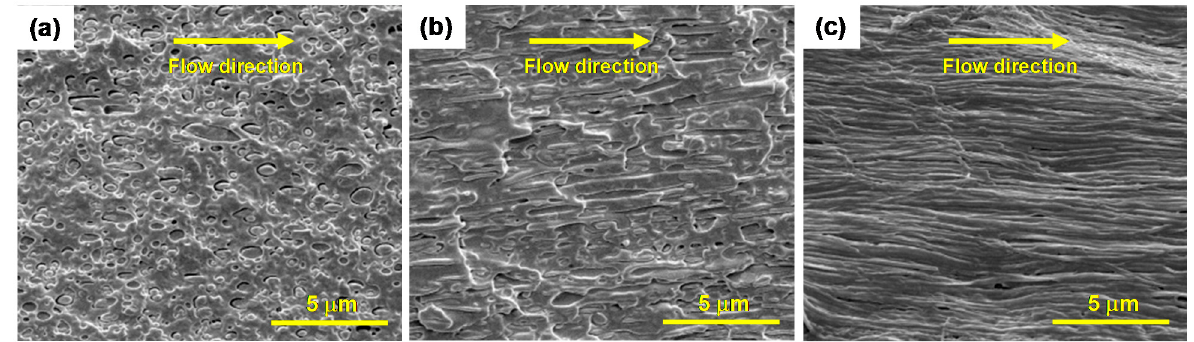
Figure 5. SEM photos of microparts with different cavity size along melt flow direction: ( a ) μ -PLA/PCL-26, ( b ) μ -PLA/PCL-20, and ( c ) μ -PLA/PCL-15.